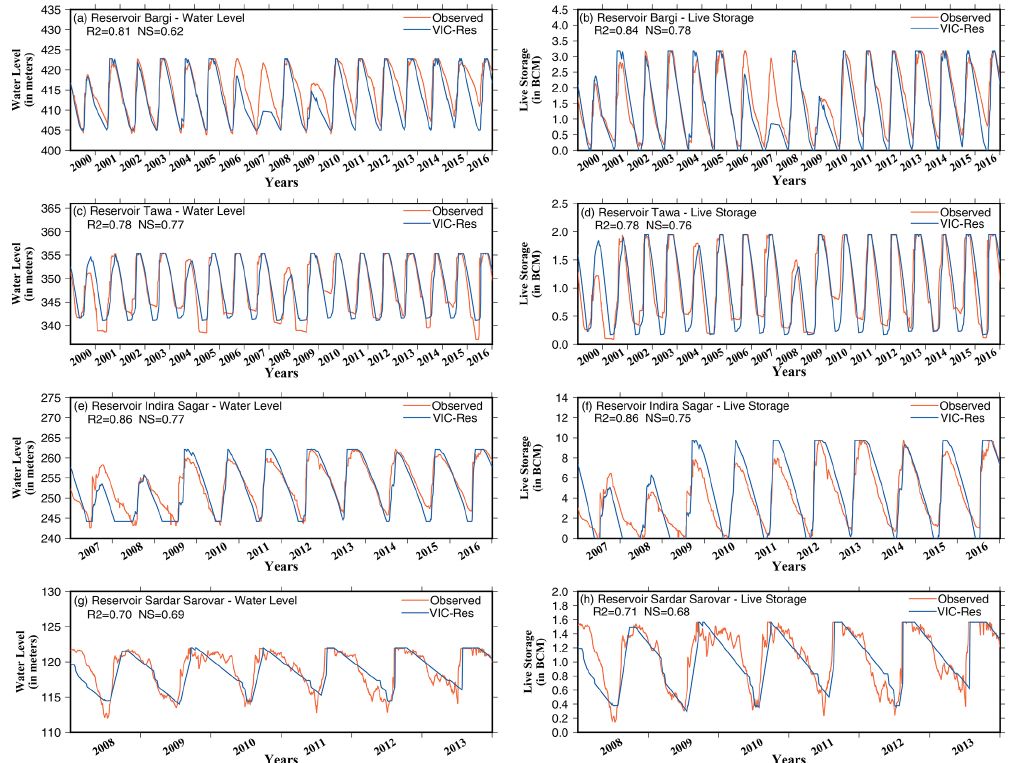
Figure 7. Evaluation of the VIC-Res model in simulating daily water level and daily live storage at four major reservoirs Bargi, Tawa, Indira Sagar and Sardar Sarovar.